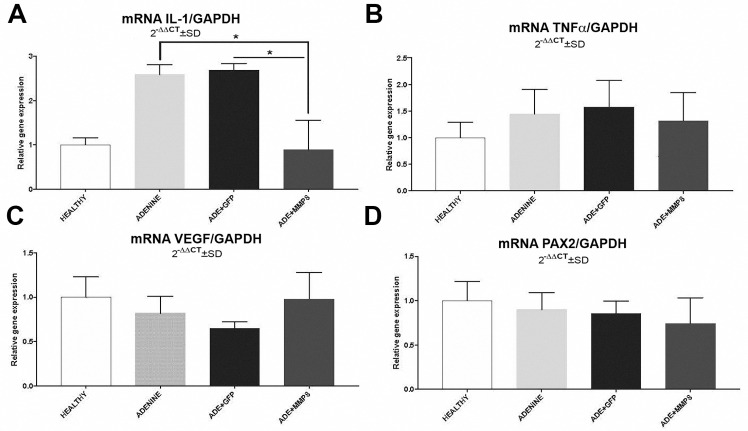
Gene expression of proinflammatory and renal tissue-remodeling genes.A) IL-1β gene expression profile showed diminution after adhMMP8 treatment (*p<0.05). B–D) TNFα, VEGF and PAX2 mRNA levels did not showed significant modifications compared to controls.